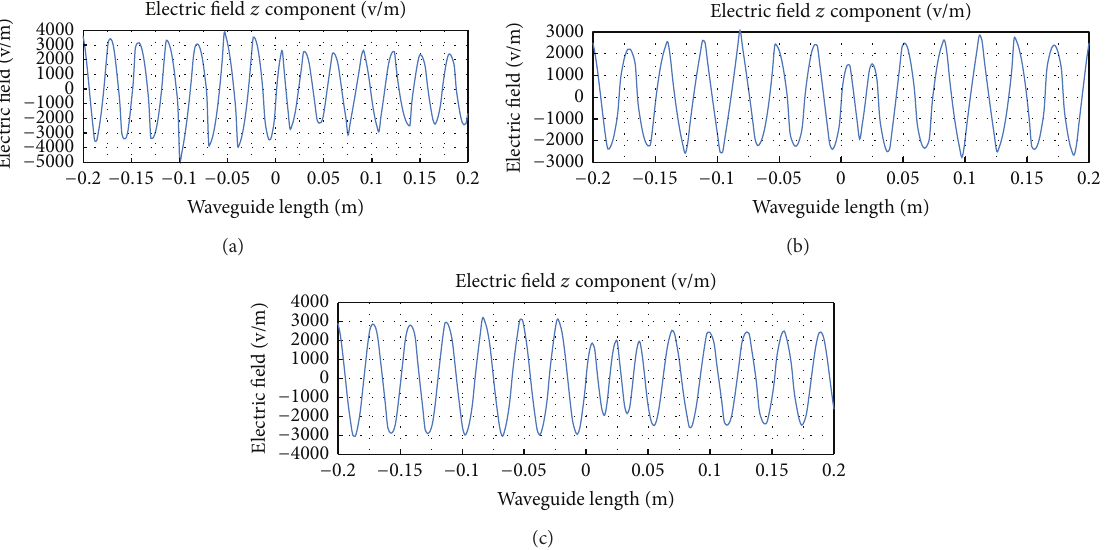
Figure 3: Electric field intensity for the 15mm, 30 mm, and 50 mm thick PTFE samples at 12GHz.